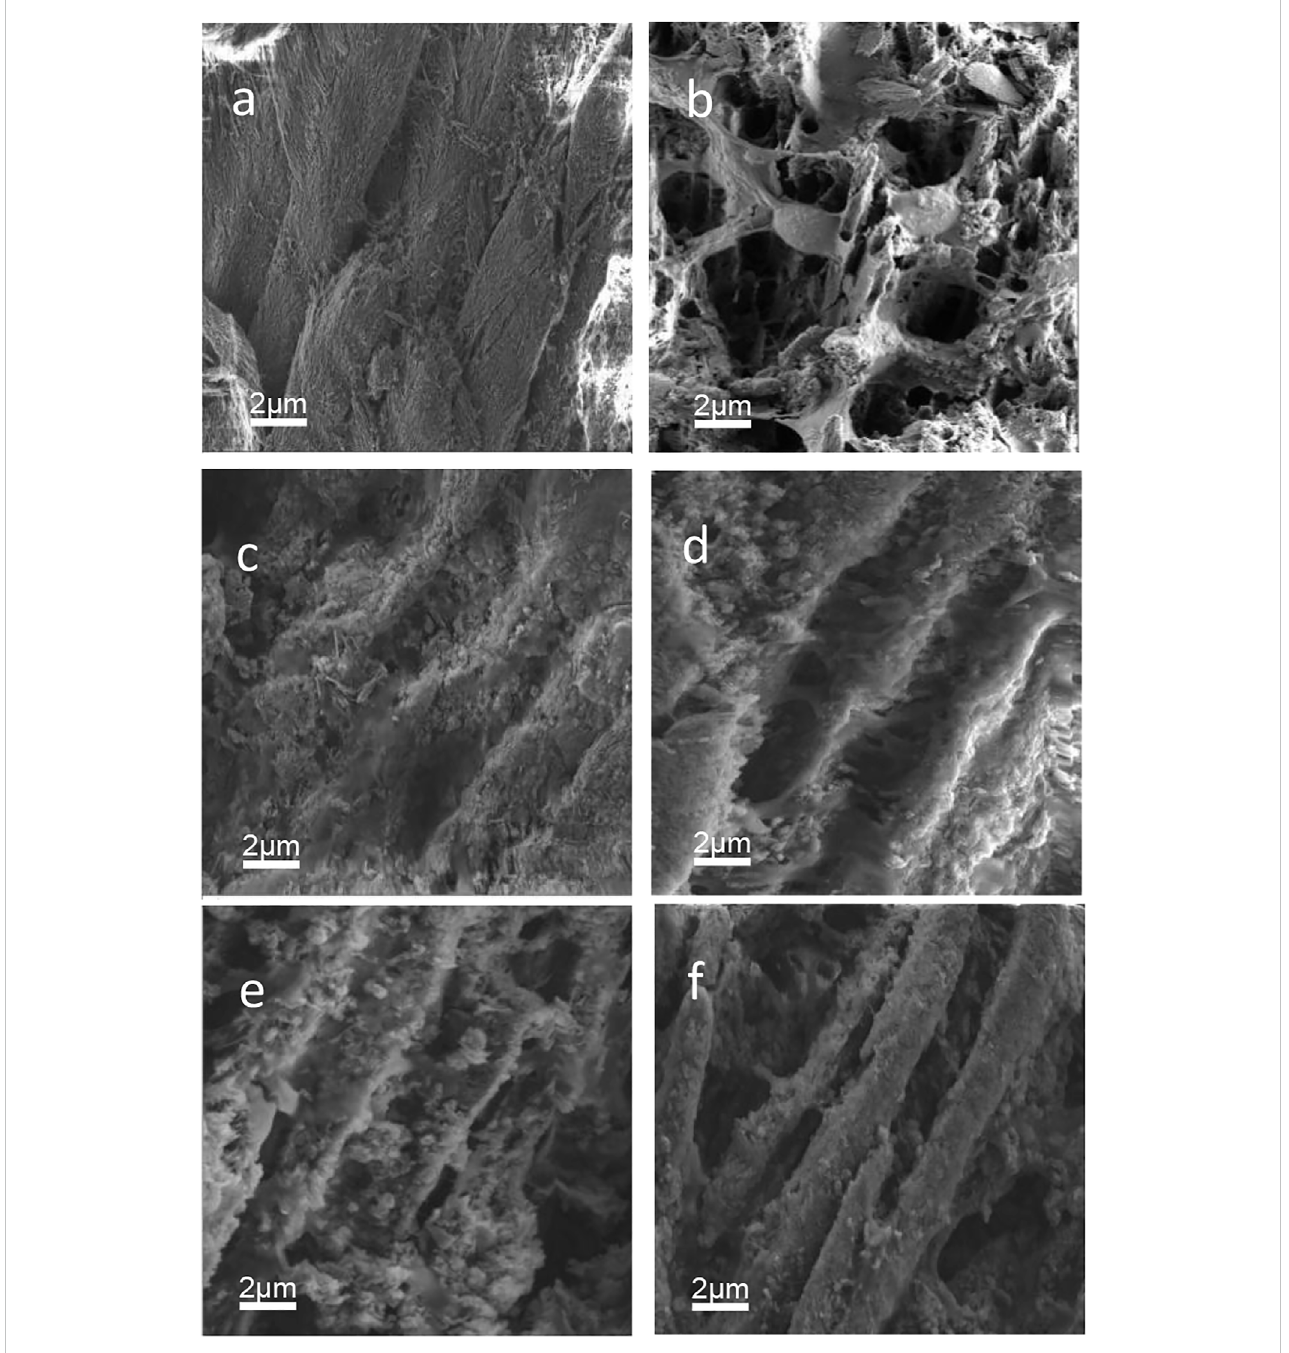
FIGURE 7 SEM pictures. (a) sound enamel. (b) demineralized enamel. (c) remineralizing medium group. (d) peptide 1 group. (e) peptide 2 group. (f) fl uoridate remineralizing medium